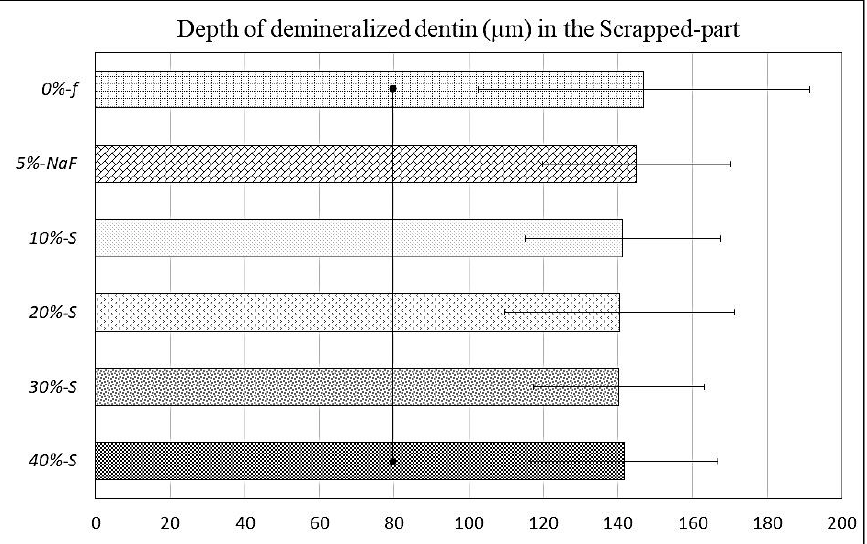
Figure 5. Graph of SS ‐ OCT data representing demineralization depths ( μ m) beneath DV scraped (removed) part, which were more than 140 μ m on average for all materials. Bars with dots indicate no significant differences ( p < 0.05).